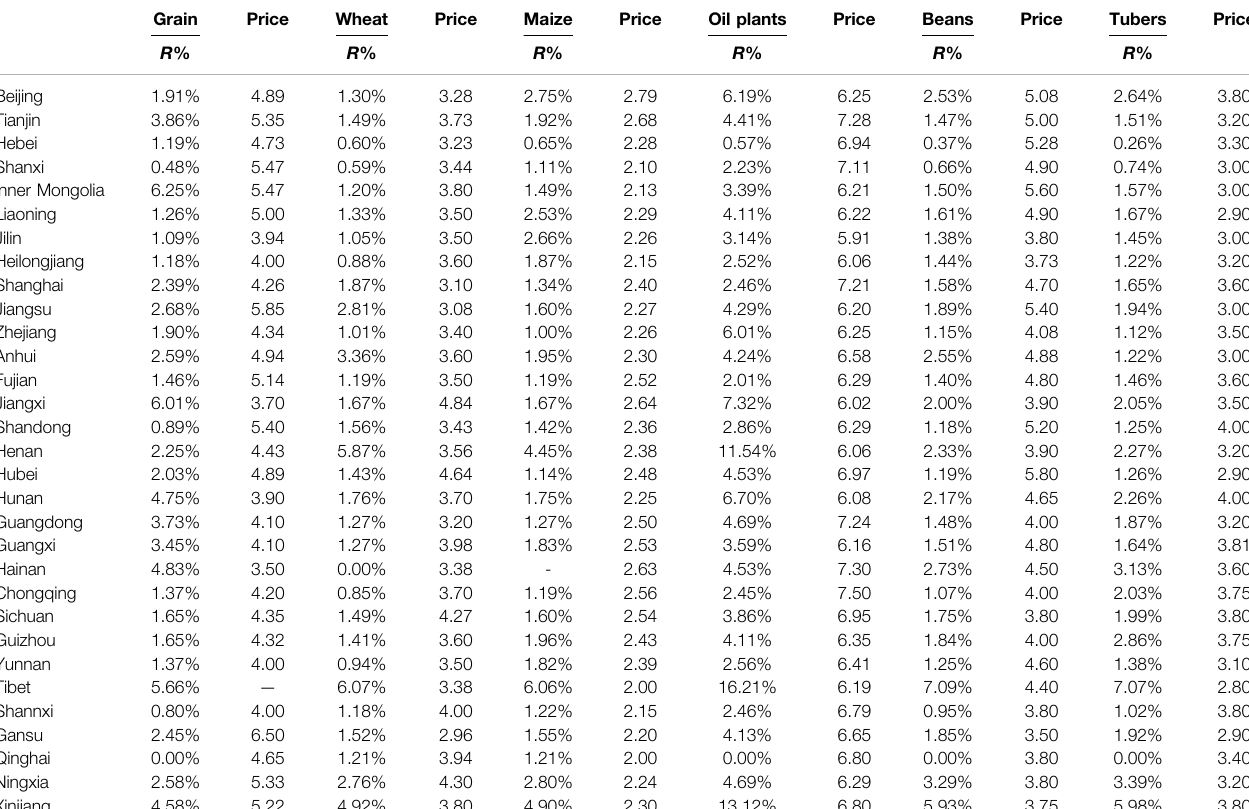
TABLE 3 | The greenness (R%) and average annual price (¥/kg) of typical agricultural products in different